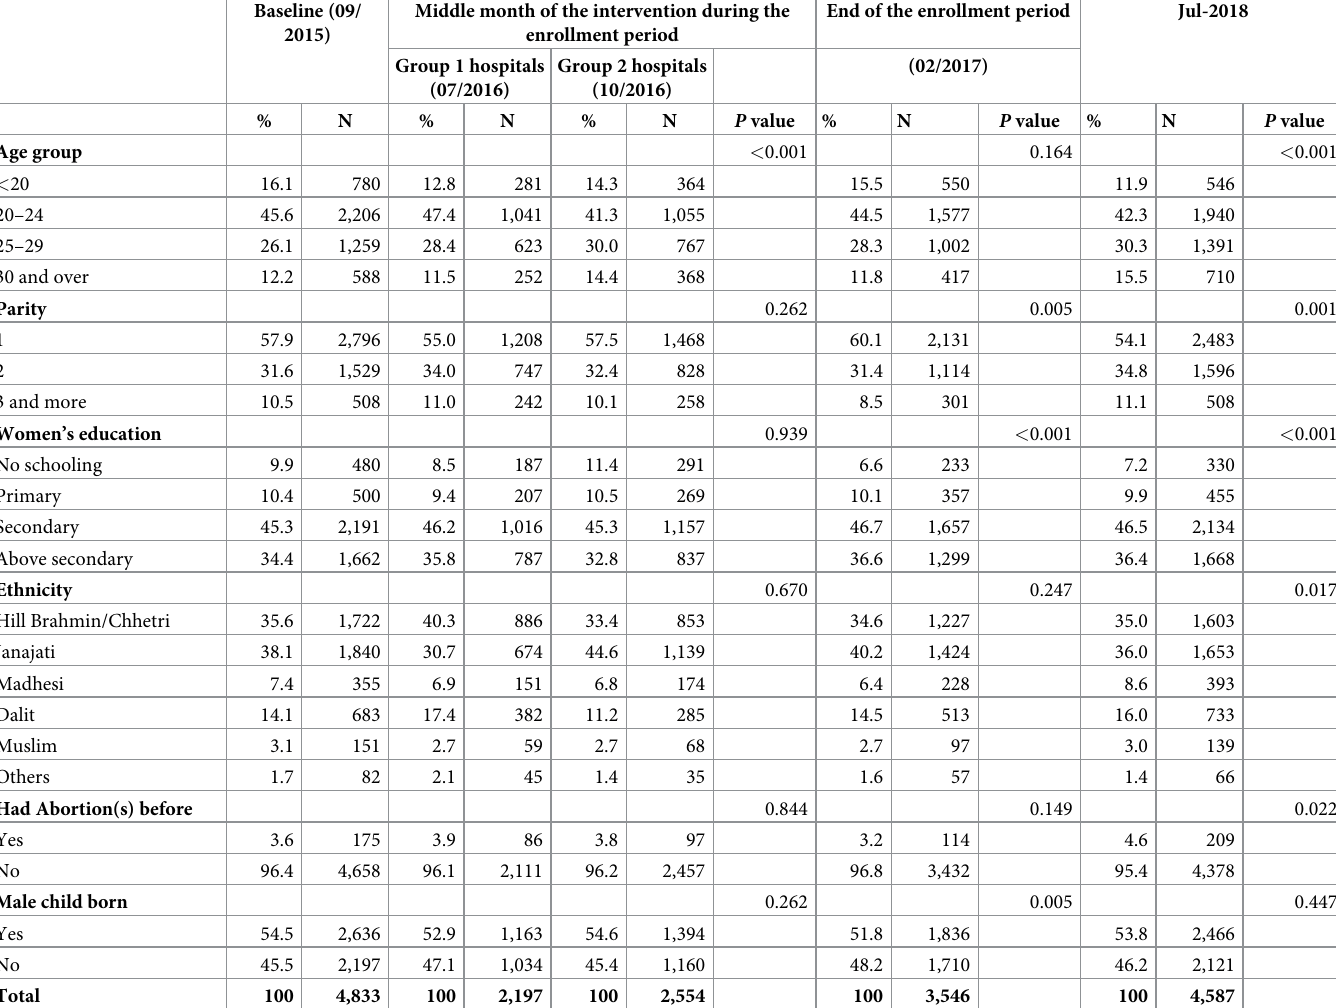
Table 1. Selected socio-demographic characteristics of women delivering in the study hospital, by month of delivery. Baseline (09/